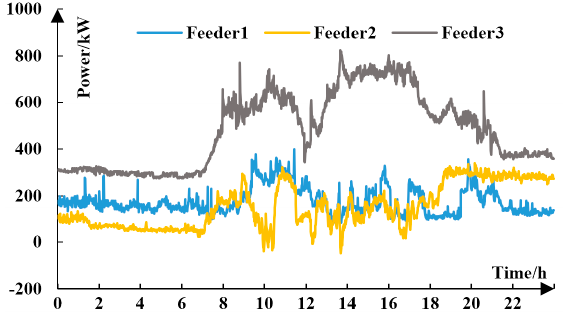
Figure 8. Net power curves of the independent feeders without ESS.